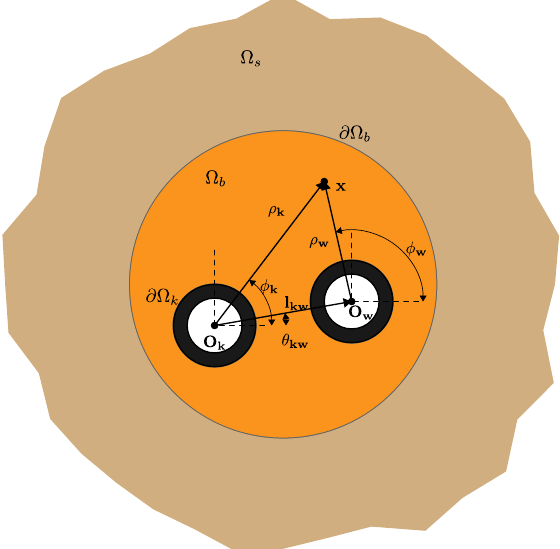
Figure 2. Computational domain of a